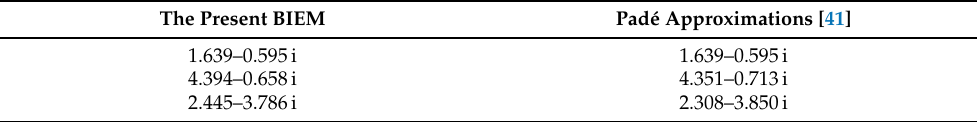
Table 3. Eigenfrequencies ˆ k 0 n of an open crack in a homogeneous space (glass): comparison with [41]. The Present